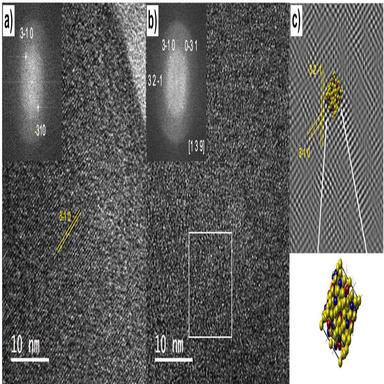
HRTEM and FFT images obtained on ternary Fe4Al17.5Si1.5 grain at the former area (a) and at the fresh area (b), together with the inverse FFT (c) of the area enclosed in the white box.